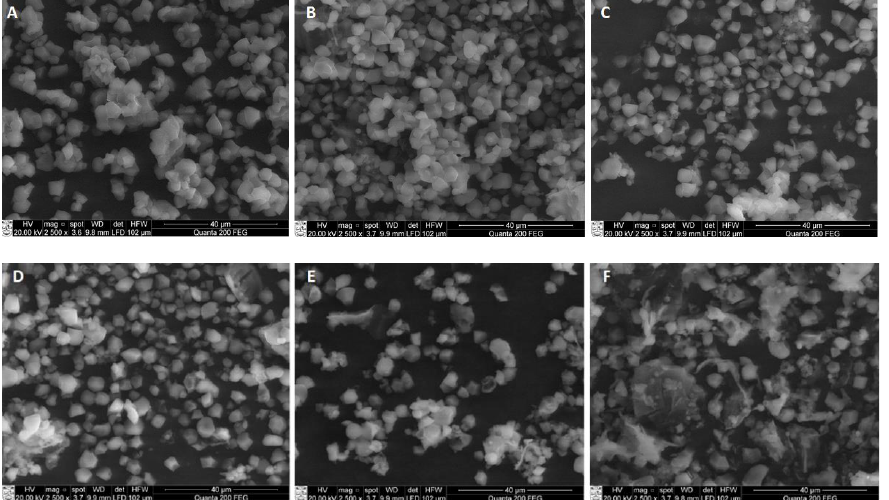
Figure 3. SEM images of native rice starch ( A ), resistant starch isolated from RB untreated ( B ) and ultrasonicated (1.8 W/cm 2 , 20 min) at 40 °C ( C ), 50 °C ( D ), 60 °C ( E ), and 70 °C ( F ) temperatures (magnification × 2500).